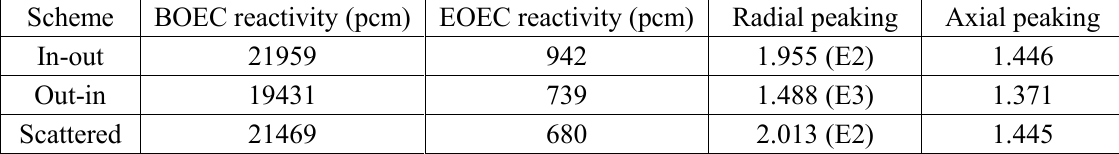
Table III: Neutronic Performances at Equilibrium Cycle for Several Shuffling Schemes